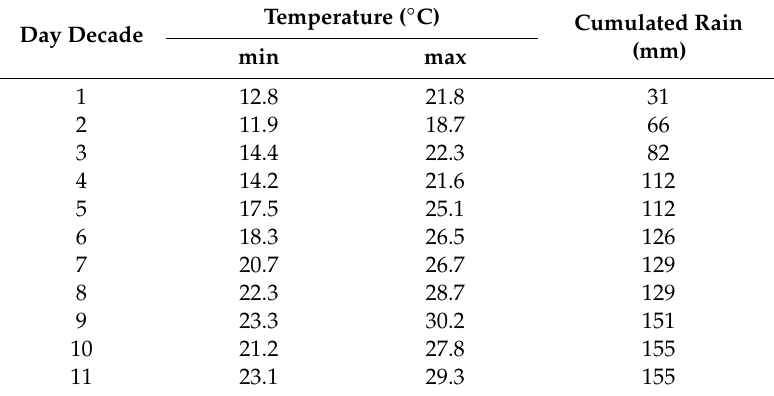
Table 7. Average temperatures (min and max) and cumulative rain for each day decade during the growing cycle (from transplanting [14 April] to harvest [4 August]) of the three local varieties. Data retrieved from Dati rete in telemisura, Protezione civile Puglia—Centro Funzionale Decentrato